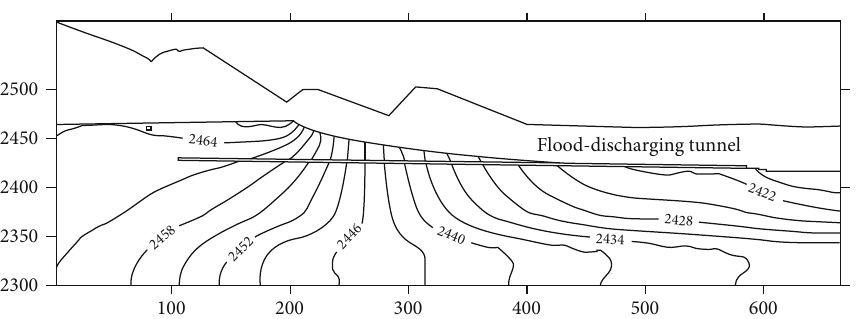
Figure 16: The isopotential distribution map of seepage fi eld about dam foundation (16-16 pro fi le).